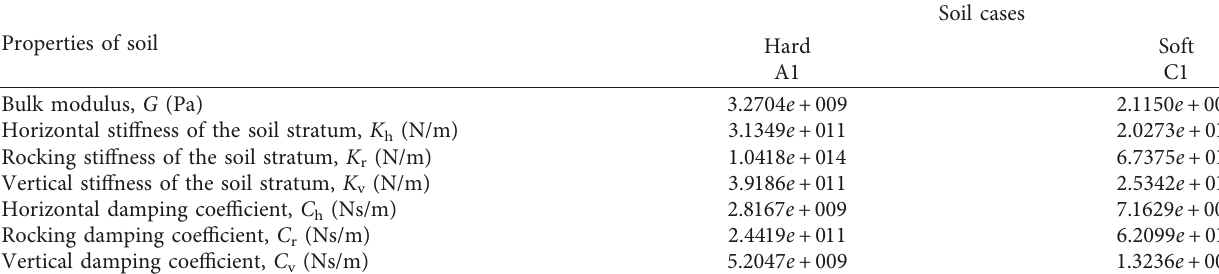
Table 4: Average soil dynamic properties of the different soil cases A1 and C1.